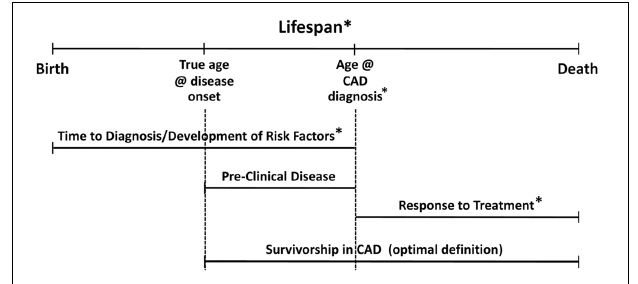
FIGURE 1 | Model for survivorship in CAD depicting temporal relationships with clinical constructs. Asterisks indicate established genetic effects in the